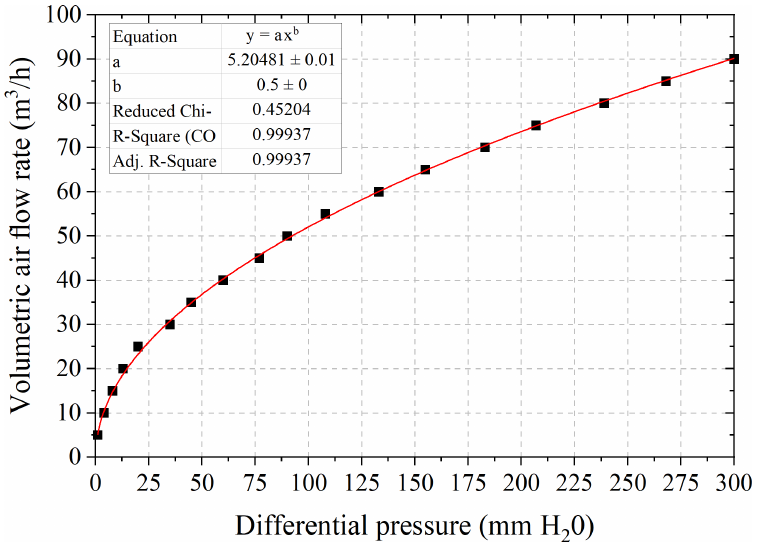
Figure 4. Characteristics of the custom venturis expressed as volumetric air flow rate vs. differen- tial